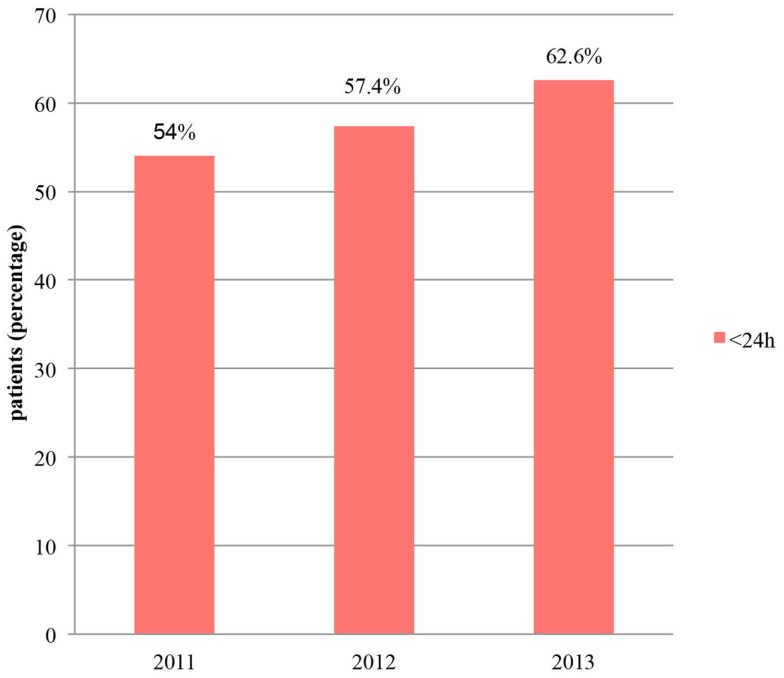
Surgery within 24 h.